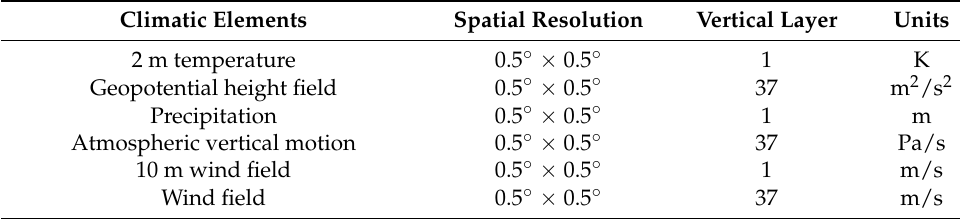
Table 1. Information on ERA-interim reanalysis used in this